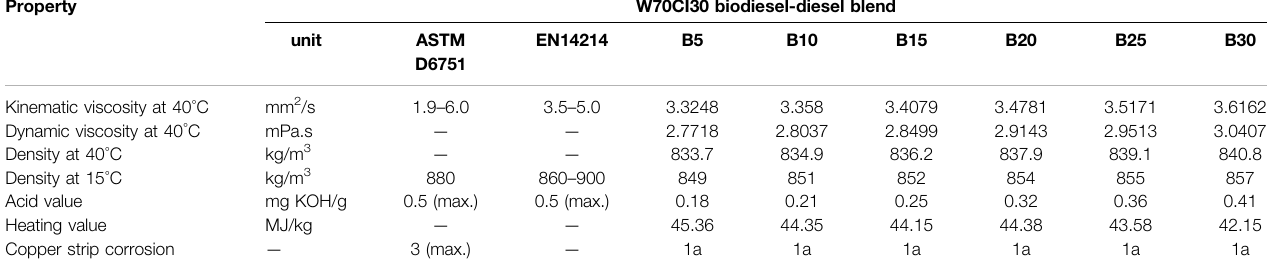
TABLE 4 | Properties of W70CI30 biodiesel blend with diesel fuel. Property